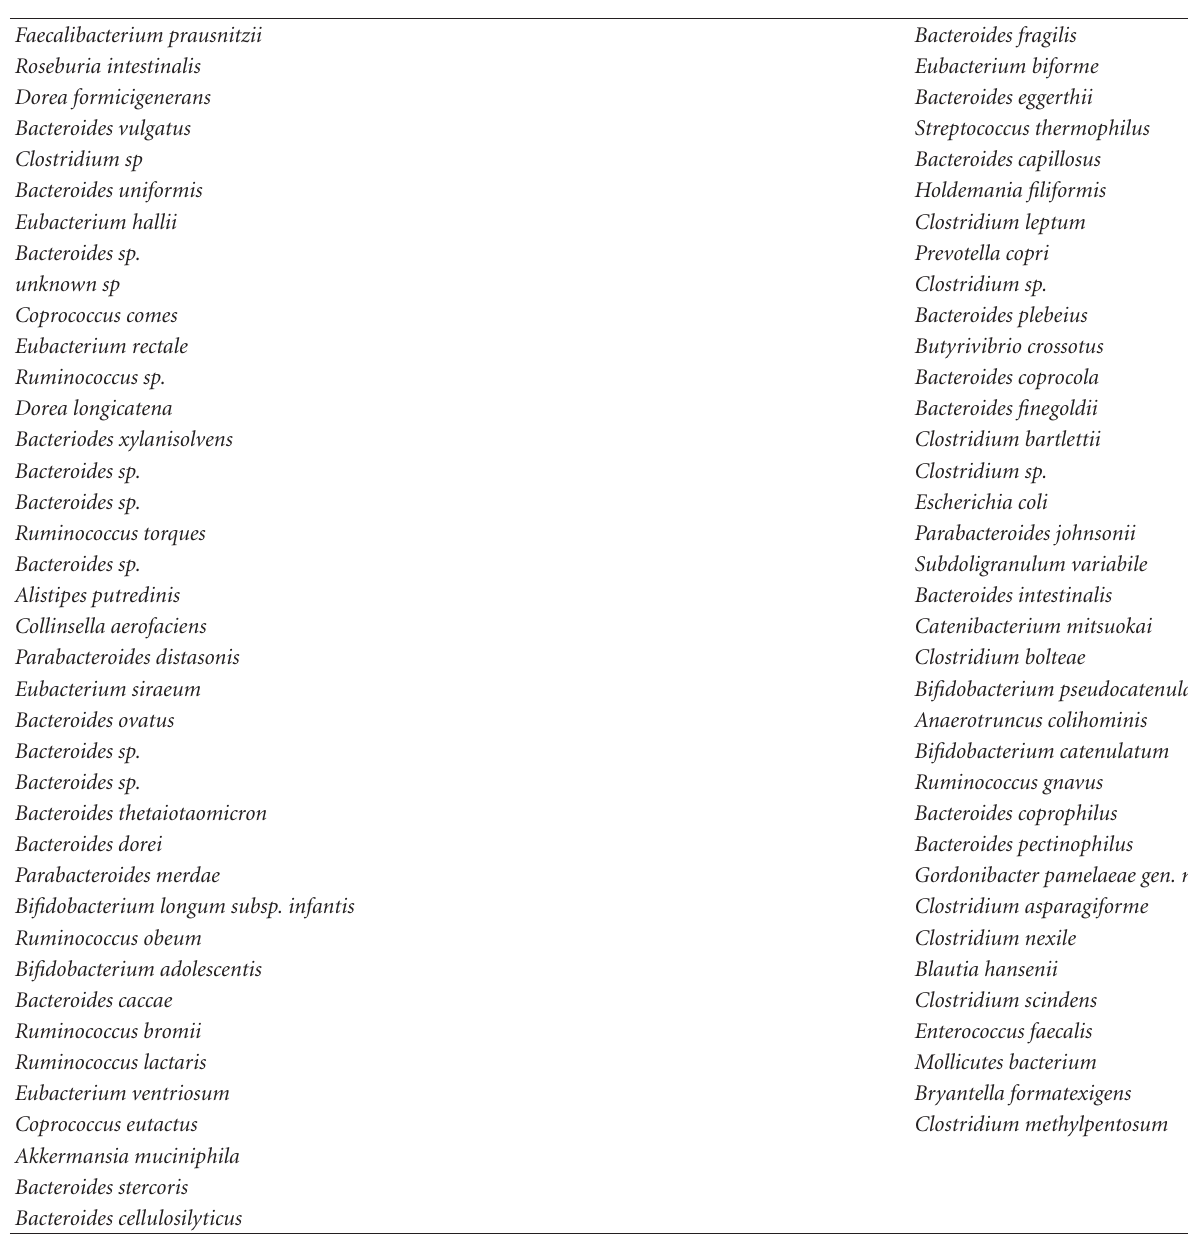
Table 2: Common species in human faeces. Seventy five bacterial species with > 1% genome sequence coverage in > 50% of 124 adult humans. After Qin et al.